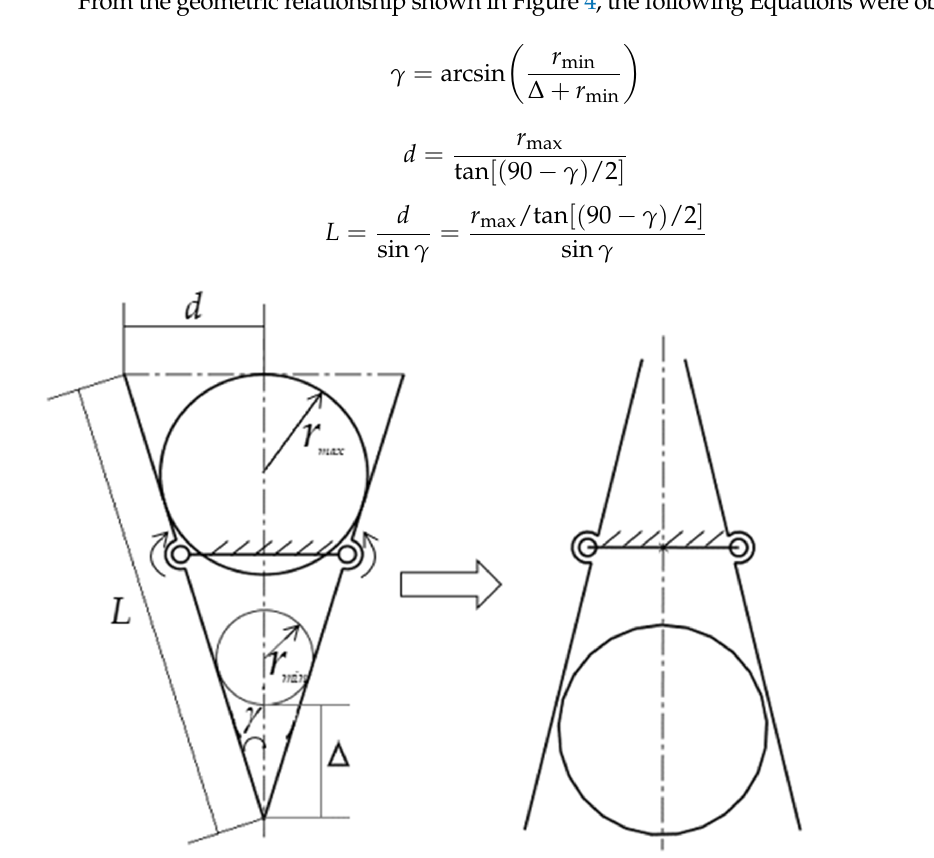
Figure 4. The tomato movement diagram in the net bag mechanism.